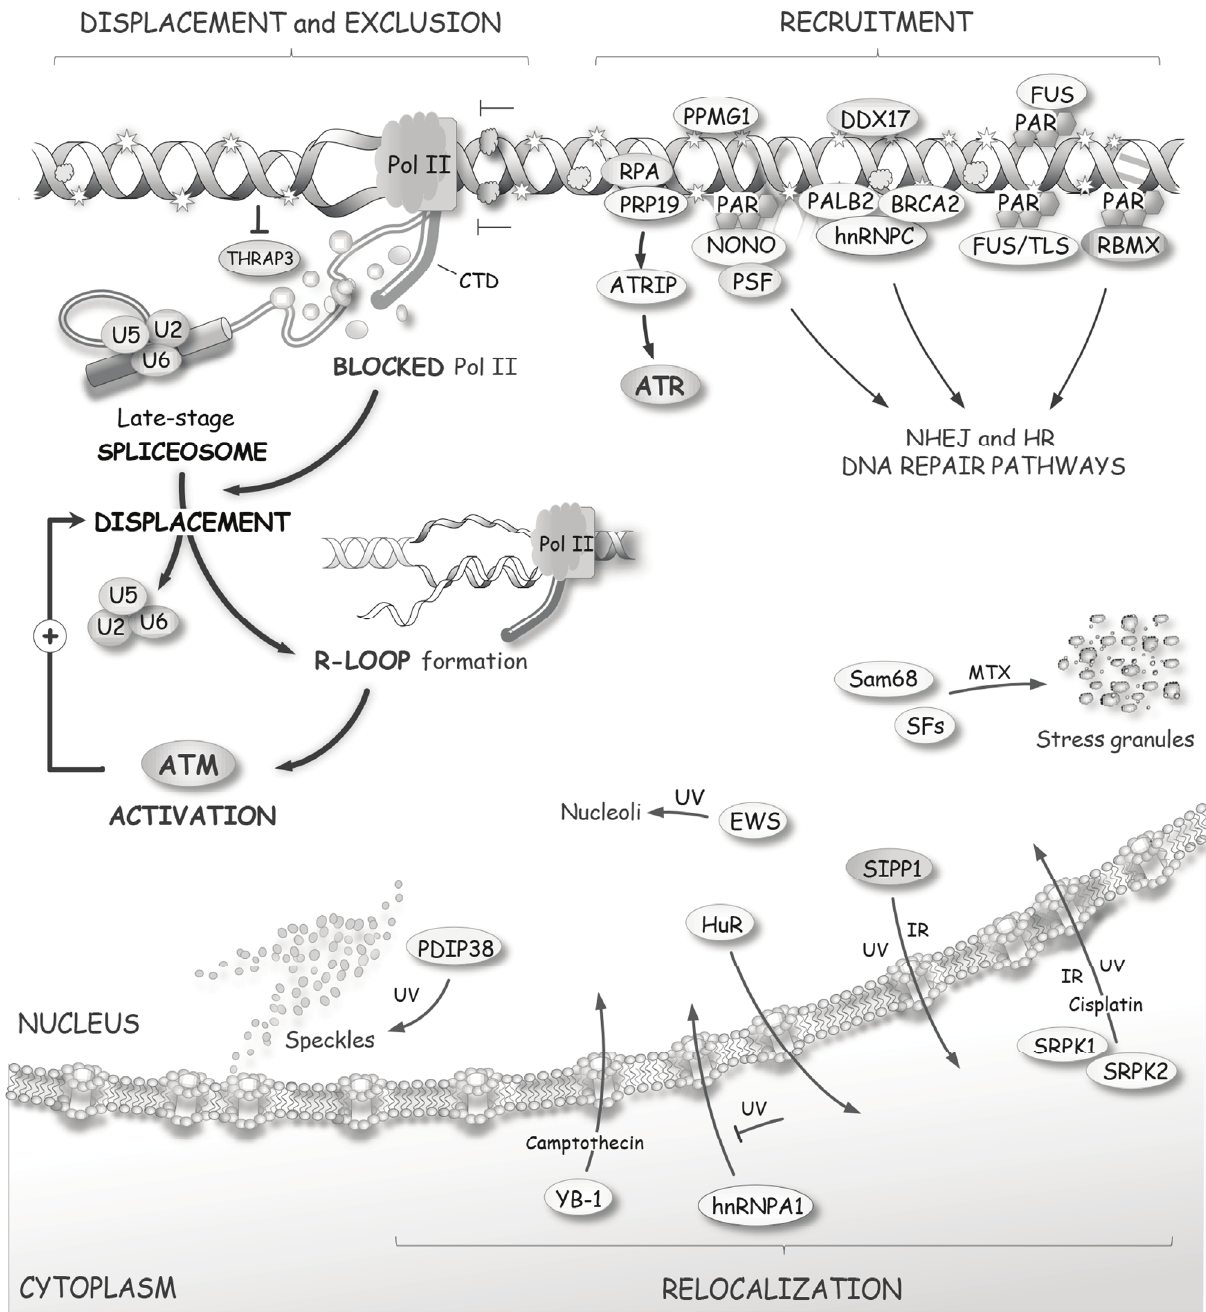
Figure 5. DNA damage affects the distribution of splicing factors. As described in the text, some splicing factors are recruited at sites of damage to participate in sensing or DNA repair. On the other hand, nascent pre-mRNAs that are associated with transcription complexes blocked at lesions will be stripped of late-spliceosome components to form RNA/DNA duplexes (R-loops) that activate ATM. DNA damaging agents also affect the subcellular localization of several splicing